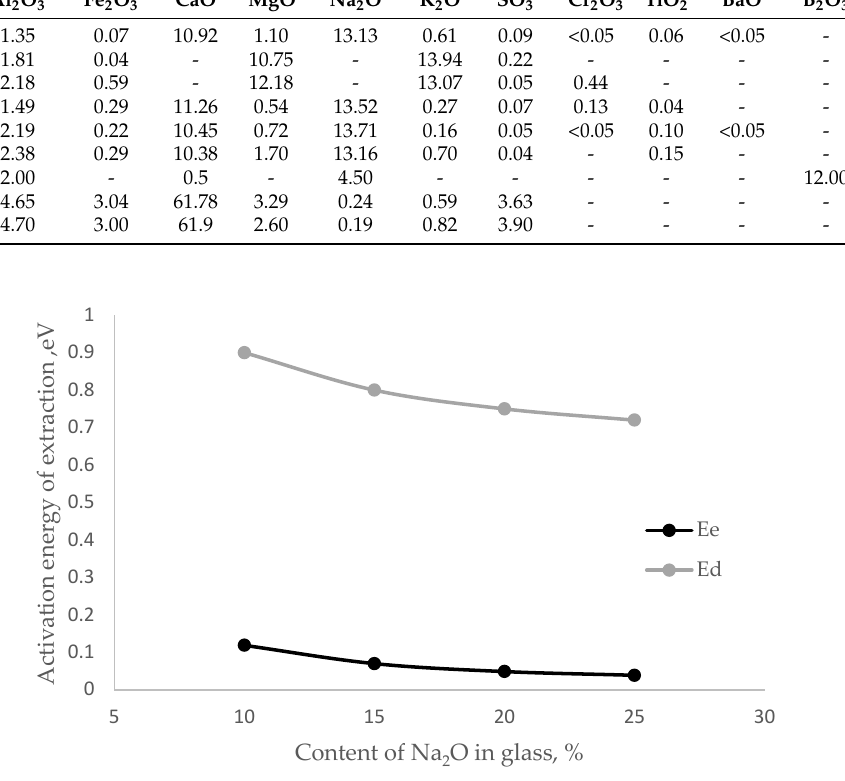
Figure 1. Dependence of the activation energy of extraction Ee and Ed on the content of Na 2 O in glass.